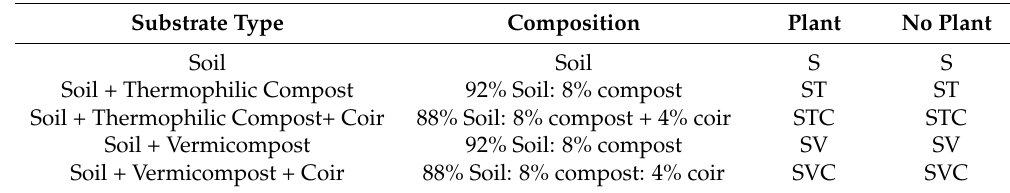
Table 1. Experimental